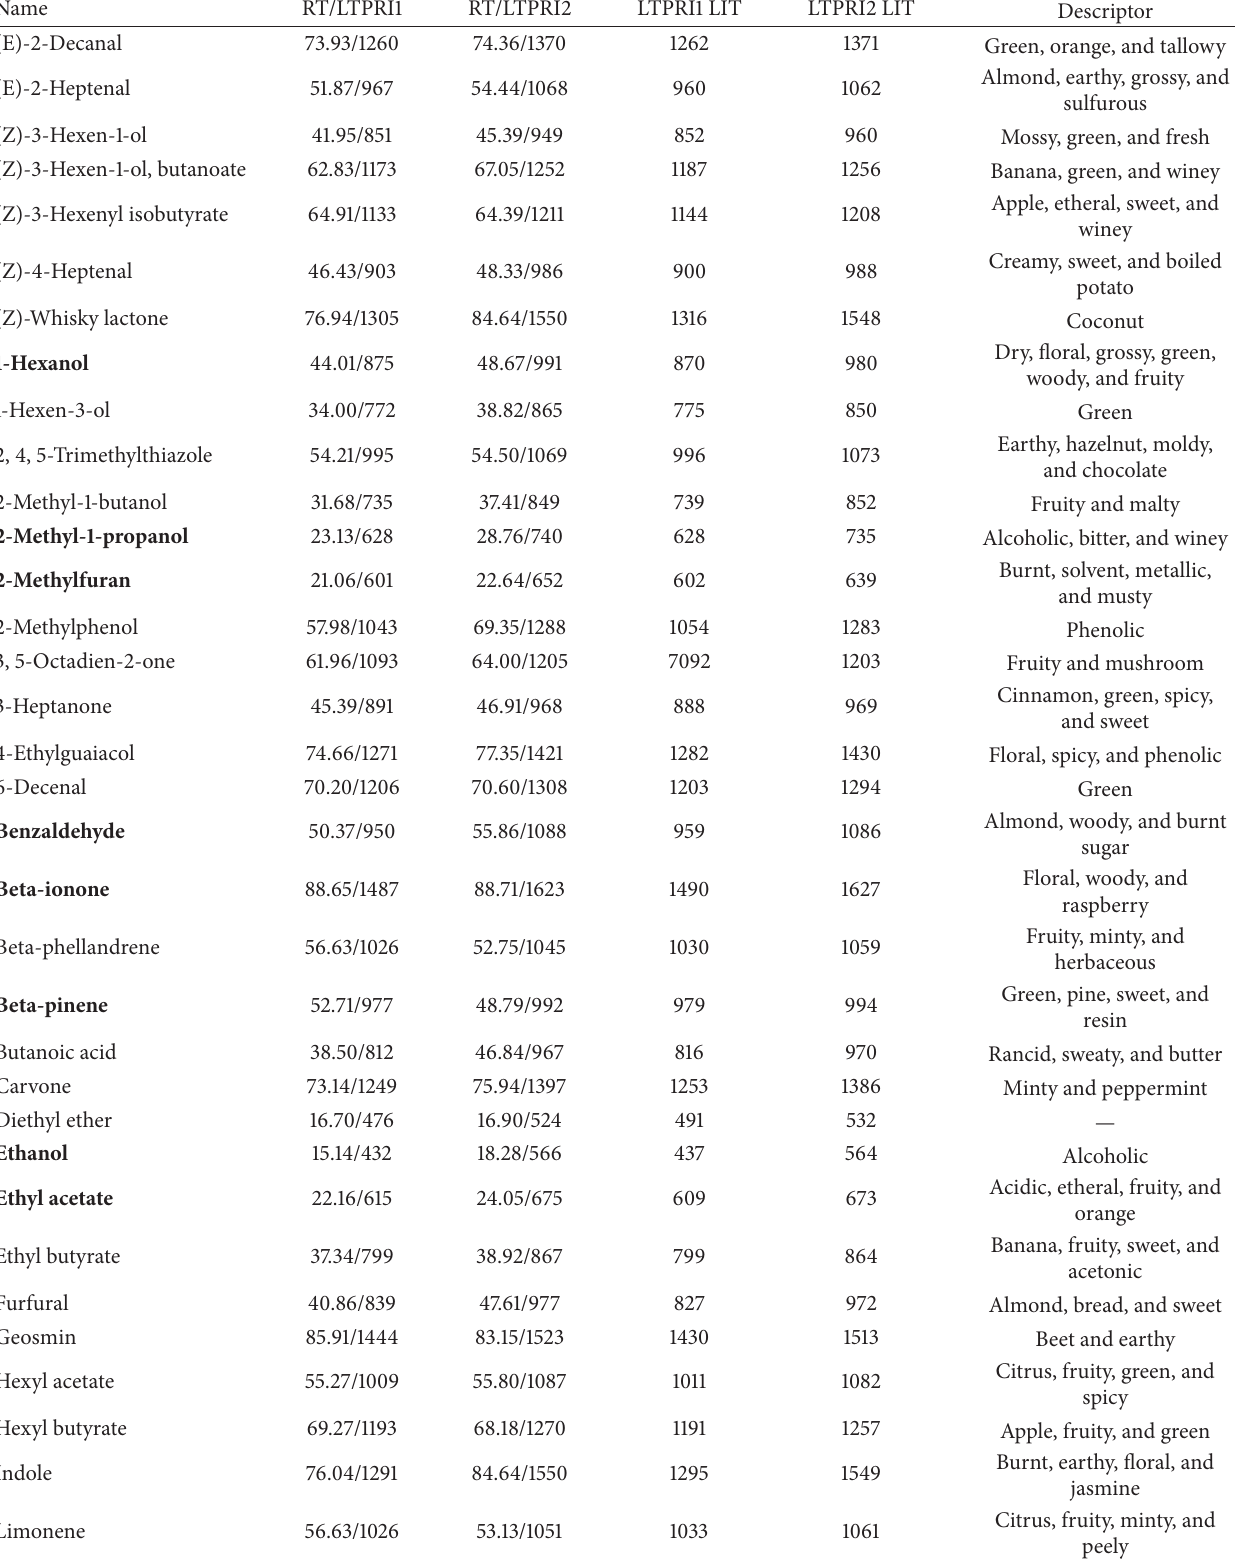
Table 4: Compounds detected in whiskey